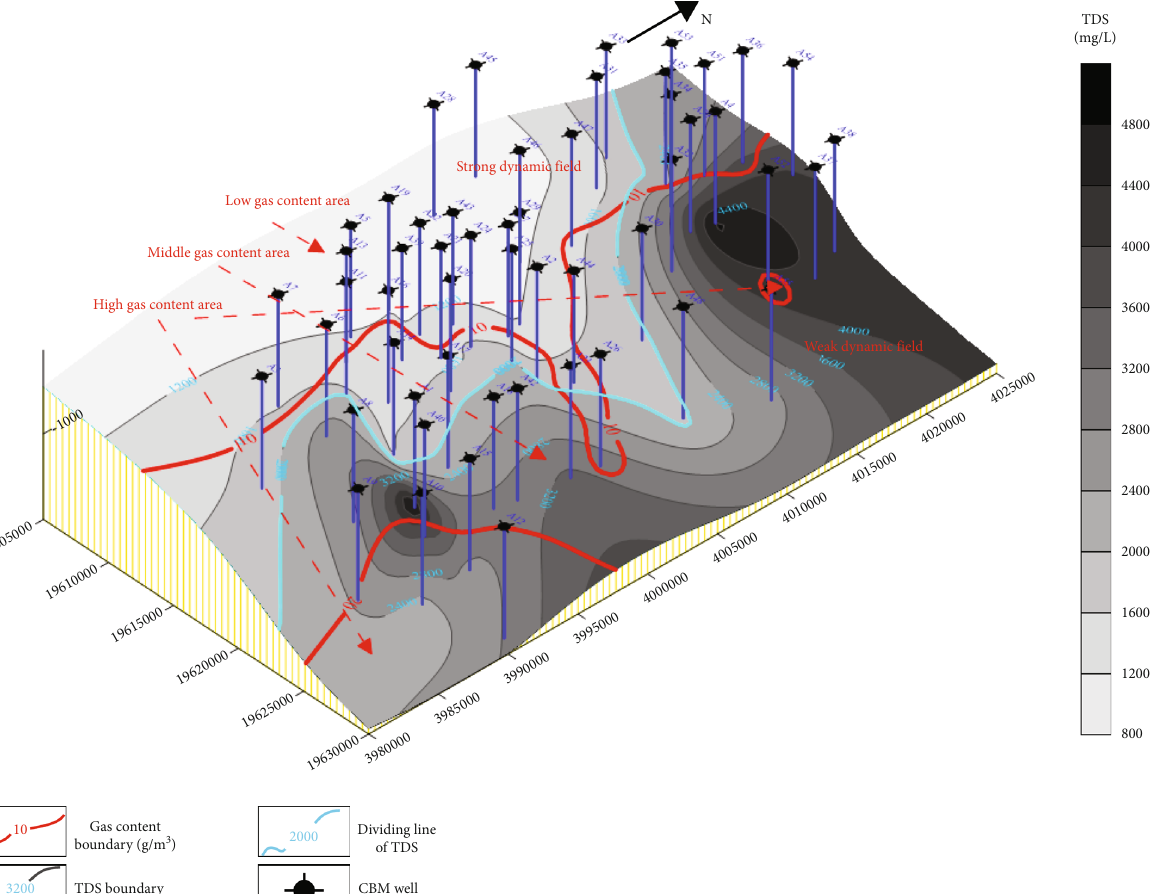
Figure 10: The distribution of CBM content under the e ff ect of hydrodynamic fi